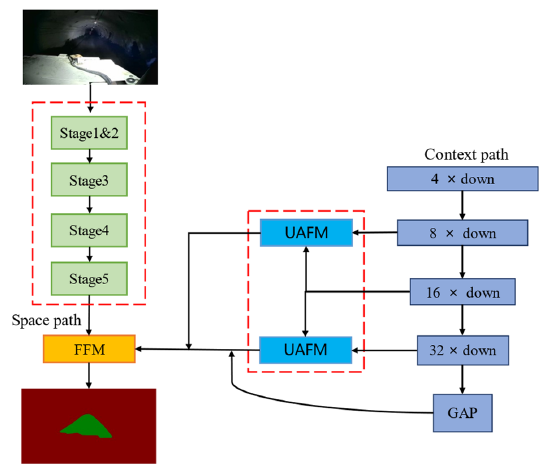
Figure 3. Improved BiSeNet